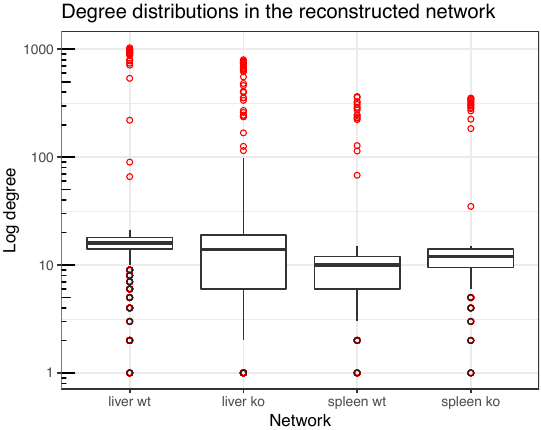
Figure 6. Boxplots representative of the degree distributions for each one of the four reconstructed networks. Identified hubs, according to the Q 3 + 1.5 × IQR criterion, are highlighted in red. The degree cutoffs, above which nodes would be considered as hubs, were 24, 39, 21 and 21, respectively for liver wt , liver ko , spleen wt and spleen ko networks. Note degree is represented in a log scale given that the reconstructed networks present a scale-free